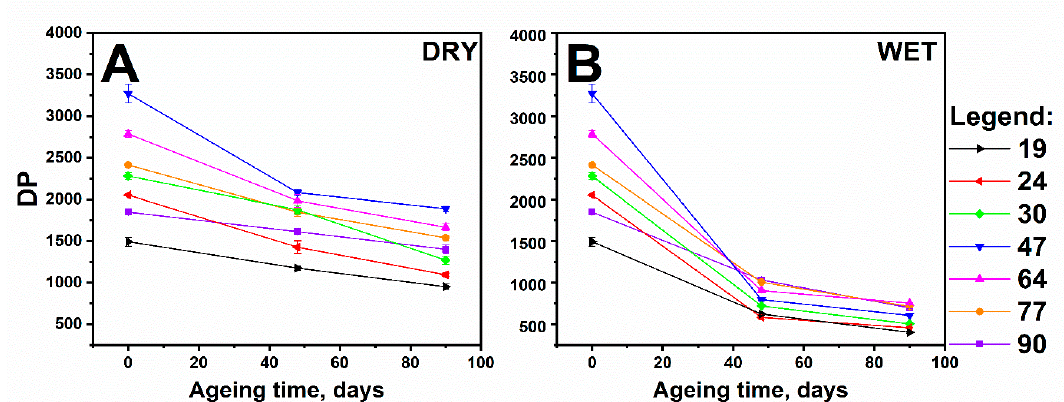
Figure 2. Degree of polymerisation (DP) values of cellulose and their changes with time, under different ageing conditions: ( A ) dry atmosphere and ( B ) humid atmosphere.